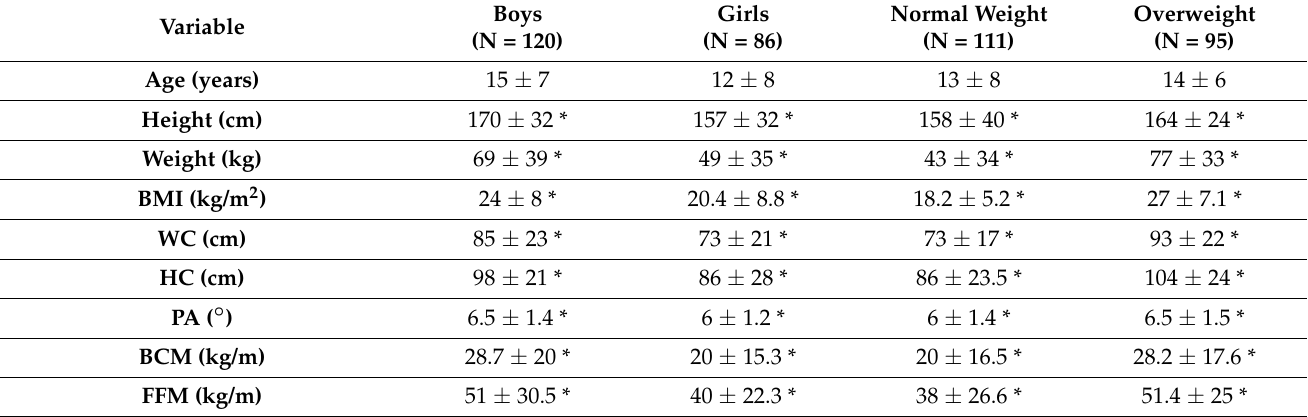
Table 1. Descriptive statistics of the researched cohort; BMI—body mass index, WC—waist